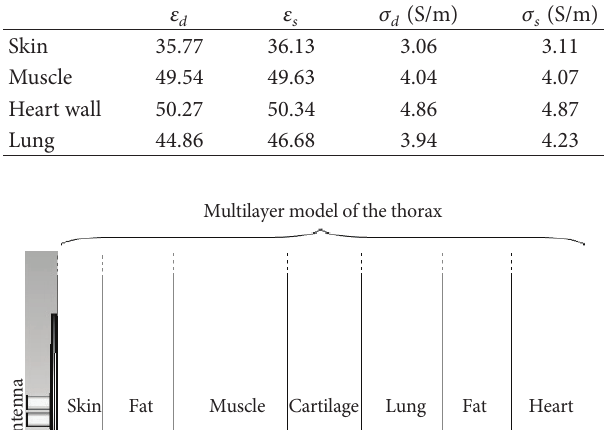
- vertical plane (b) at 4, 6, 8, and 10GHz. 𝑦𝑦 𝑧𝑧 and ). 𝜀𝜀 𝑠𝑠 𝜎𝜎 𝑠𝑠